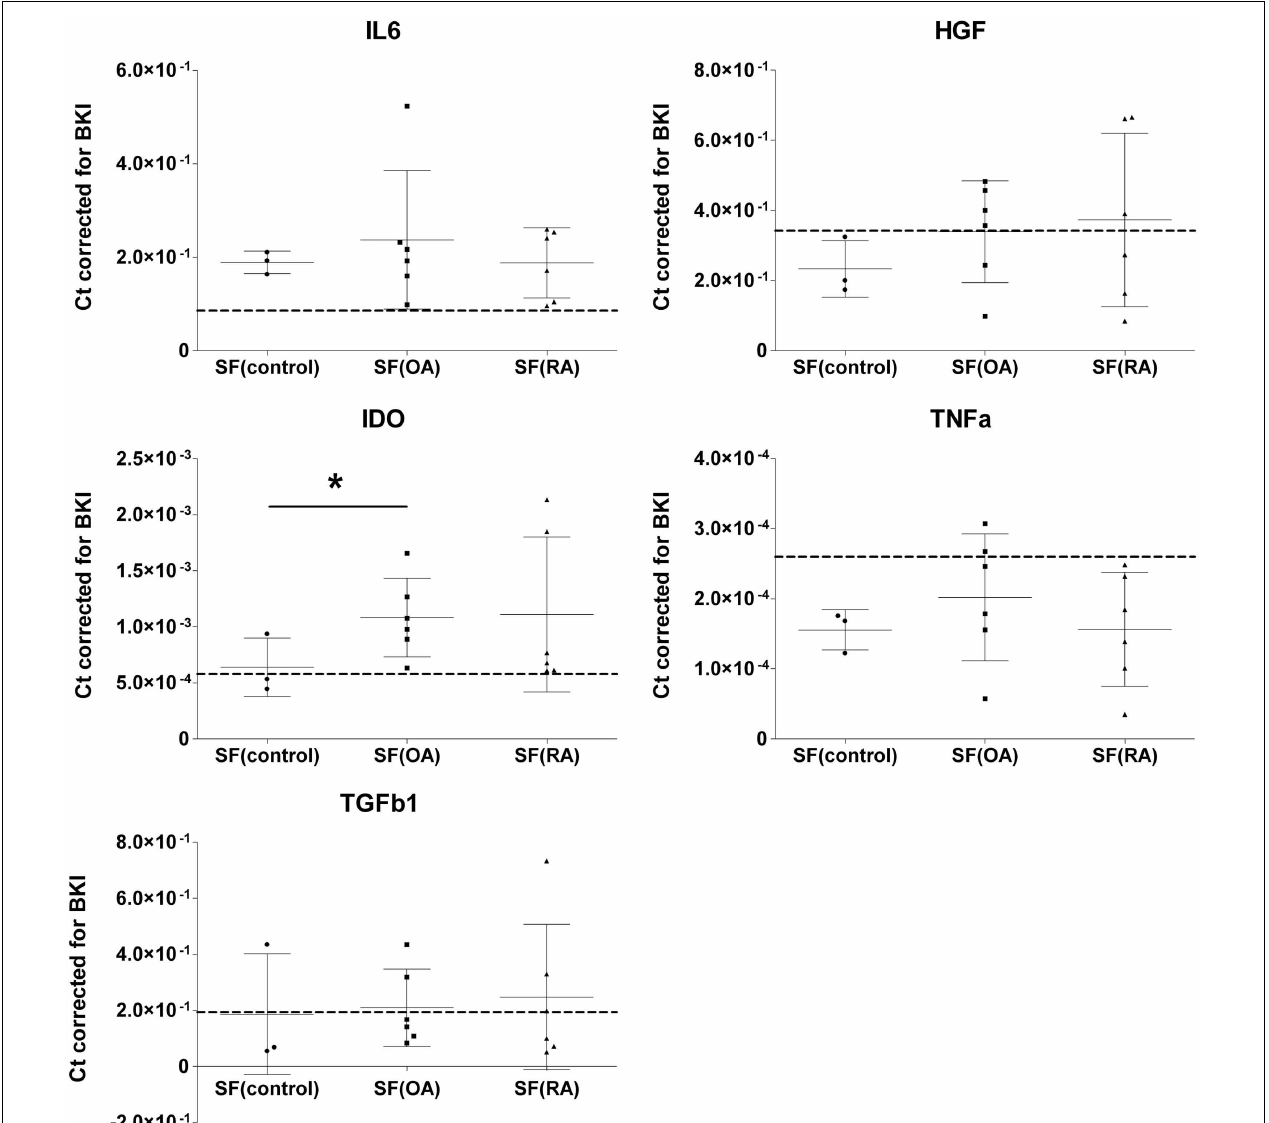
donor (Mean ± SD). SF, synovial fluid; SF(control, OA, and RA) culture media of the MSCs supplemented with respectively non-pathological SF, OA SF, and RA SF. IDO, indoleamine 2,3-dioxygenase; IL-6, interleukin-6;TNFa, tumor necrosis factor-alpha;TGFb1, transforming growth factor-beta 1; HGF, hepatocyte growth factor; BKI, BestKeeper Index consisting of: GAPDH, UBC, and HPRT. *Expression in MSCs after culture in SF(OA) different from SF(control) by mixed linear test of these two conditions, P <